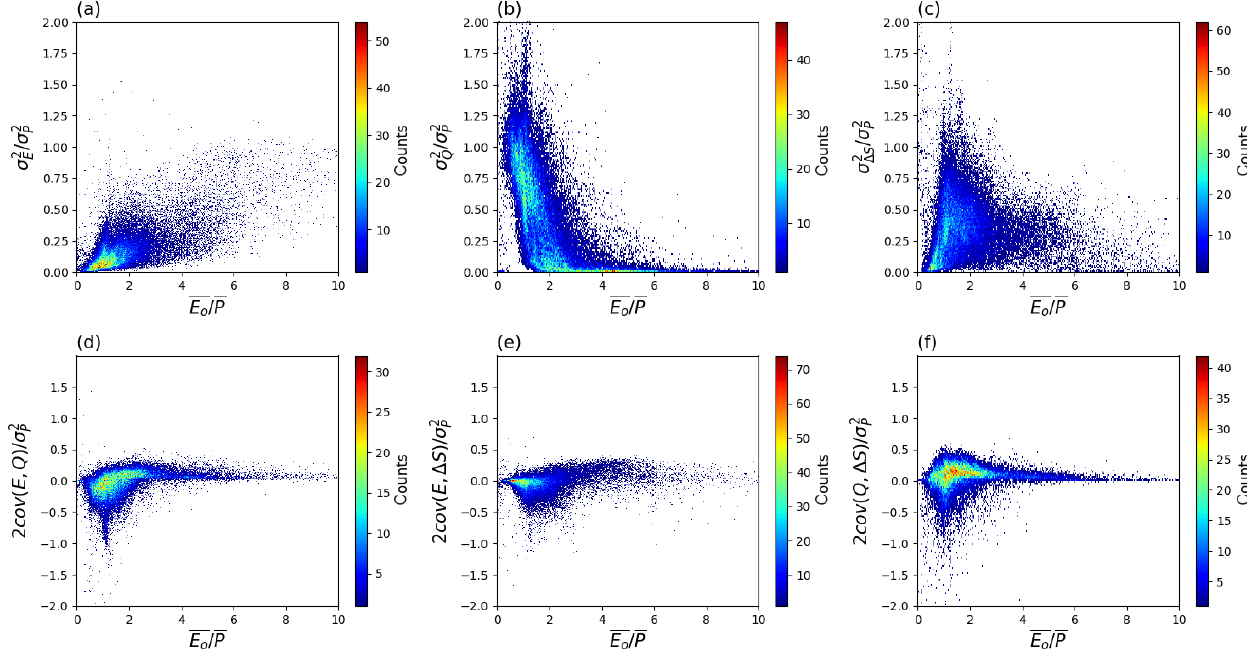
Figure 6. Relation between water cycle variances and covariances (see Fig. 3b–g) as a fraction of the variance of P ( σ 2 index ( E o /P ) coloured by density. Note that we have multiplied the covariance components by two (see Eq.